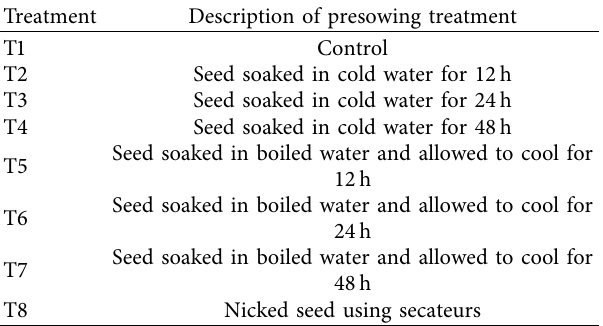
Table 1: Details of pretreatment methods used.